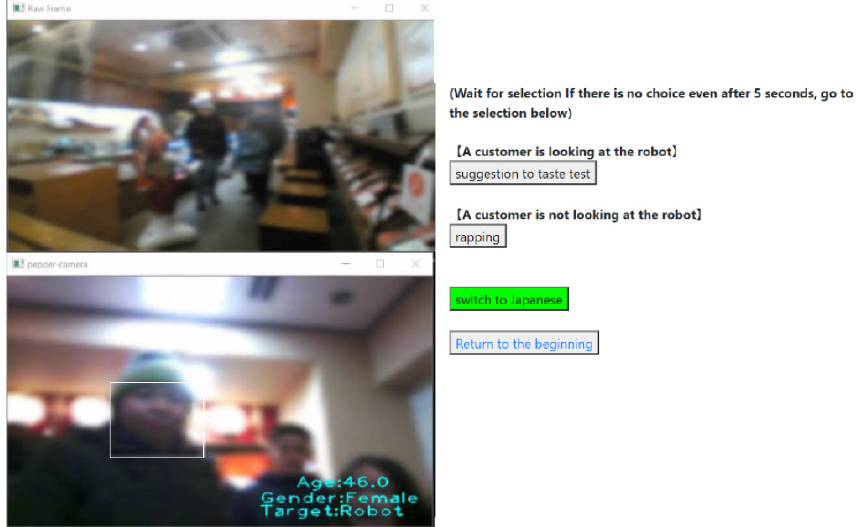
Figure 15. User interface for the robot’s operation.